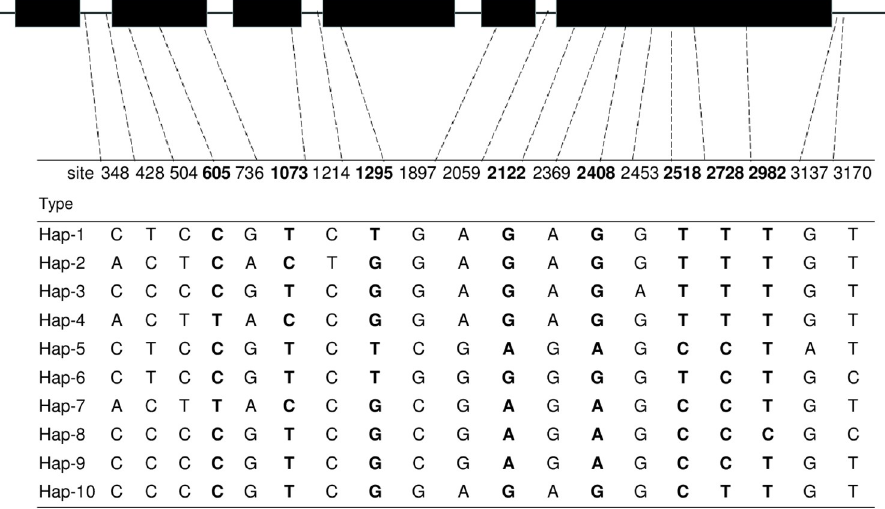
Fig 1. Haplotype variation of HMA3-D1 in the 80 accessions of Ae . tauschii . Exons are depicted as a black box. Exonic polymorphisms generating a changed peptide are indicated in